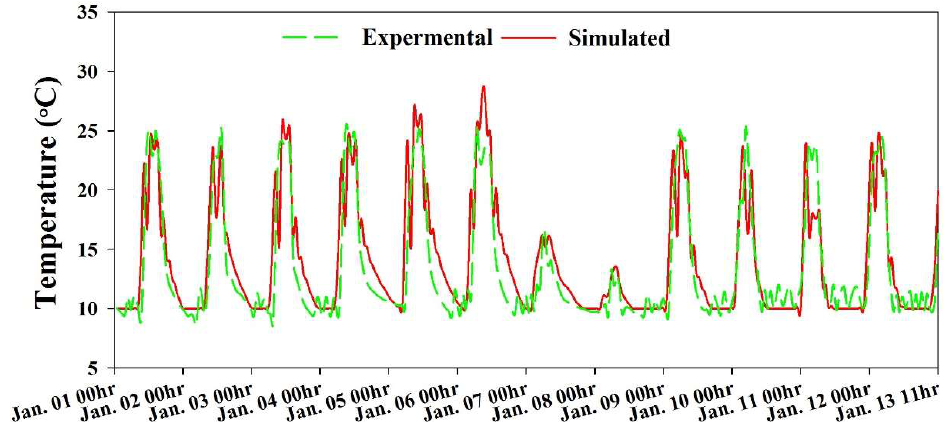
Figure 9. Computed versus. measured internal air temperature of greenhouse with temperature- controlled vents and heating setpoint.